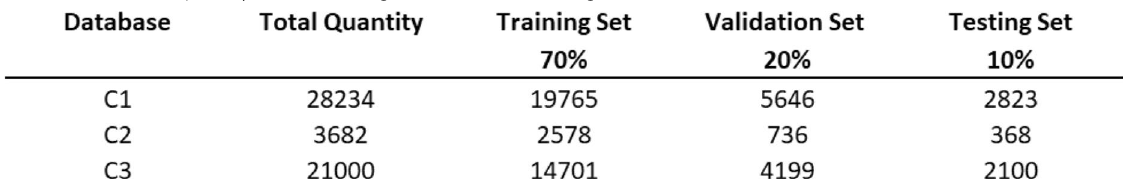
Table 3 Ratio and quantity for the training, validation, and testing sets